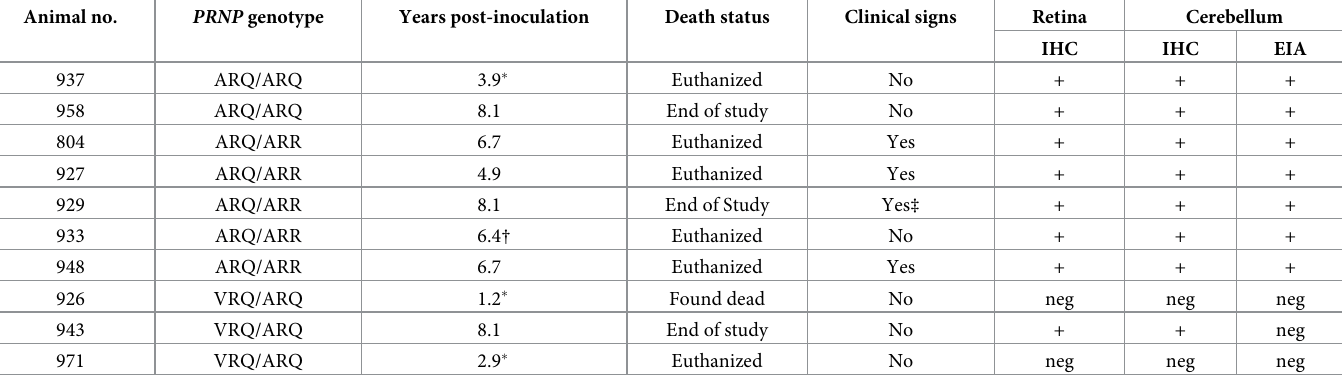
Table 1. Results of atypical scrapie transmission in Suffolk sheep. Animal